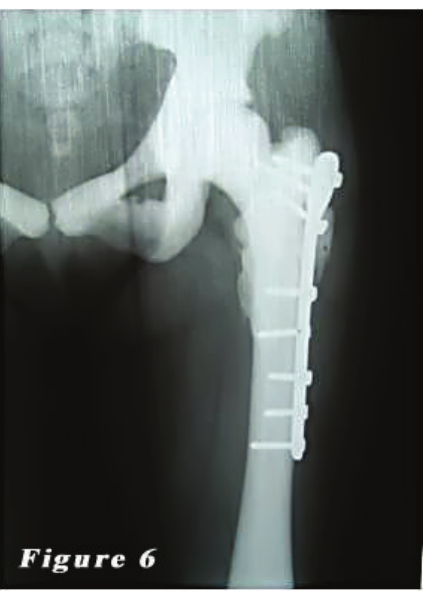
Figure 6: Her last left femur radiography. It looks like fracture union.